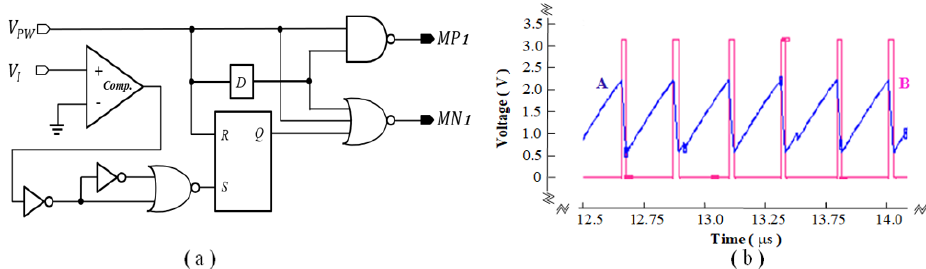
Figure 6. Proposed gate driver circuit: ( a ) gate driver circuit; ( b ) signals of ramp (A) and clock (B).